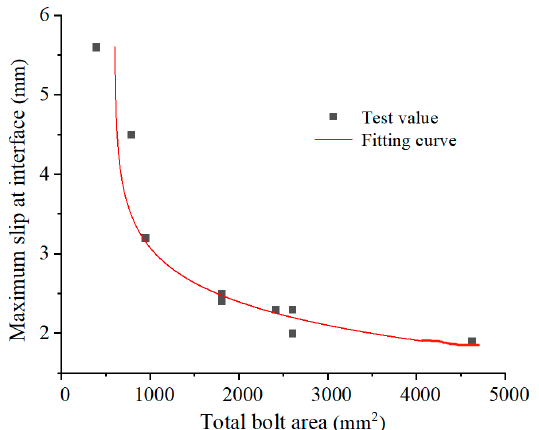
Figure 13. The maximum slip at interface in terms of the total bolt area.